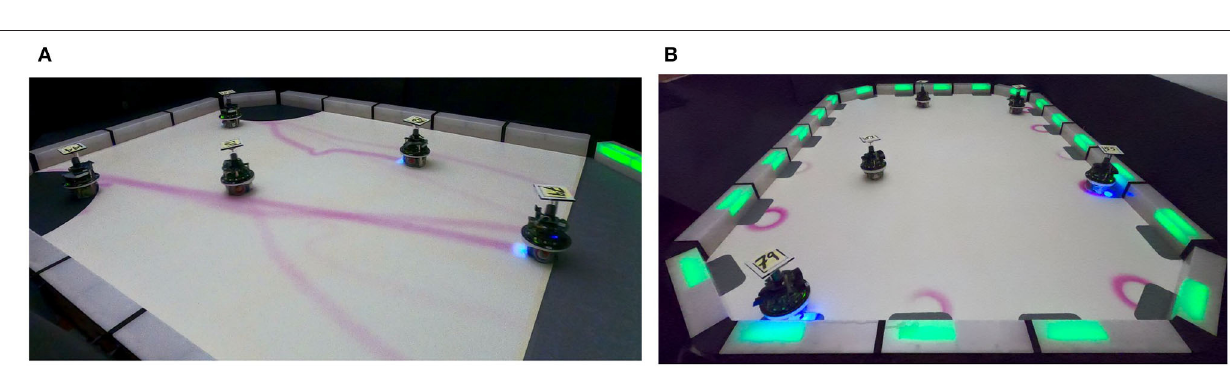
swarm explores a significantly wider area than in Basic- C OVERAGE (Wilcoxon signed–rank test, confidence 95%) (see Figure 10A